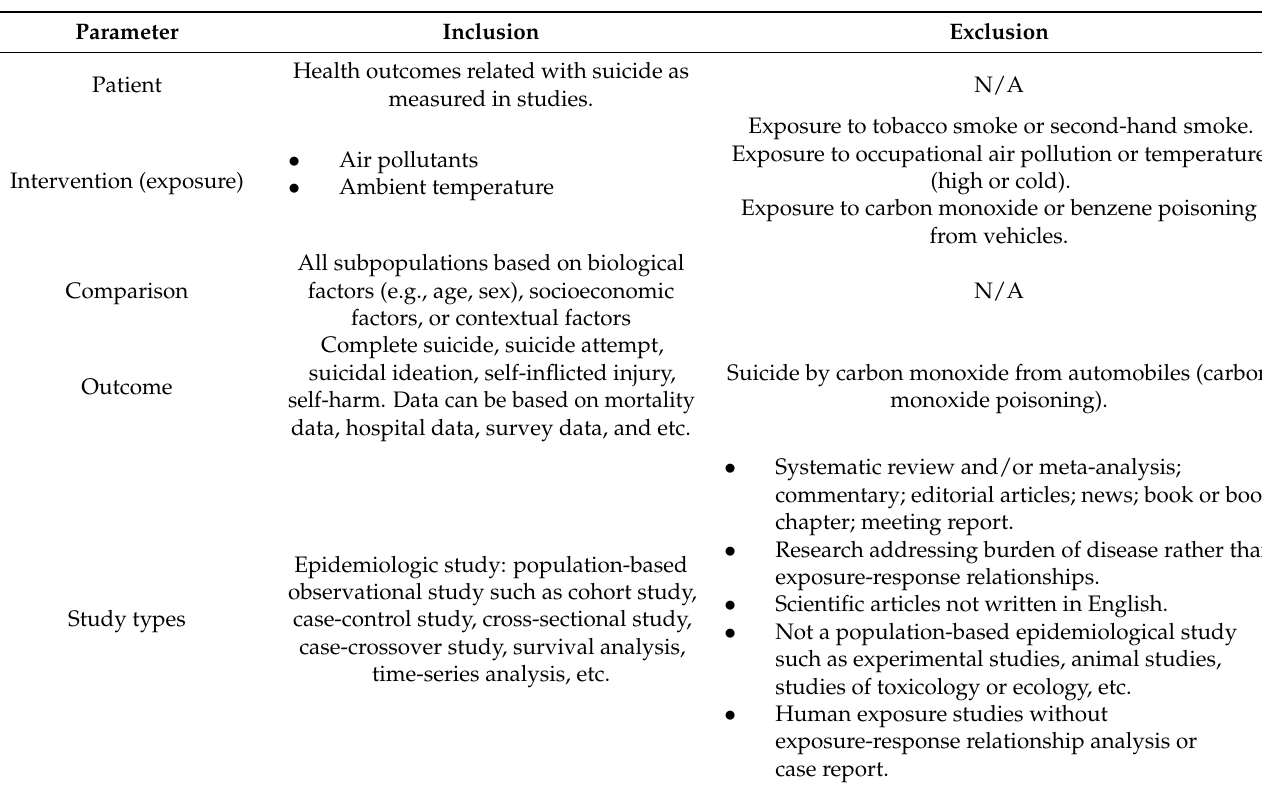
Table 1. PICOS inclusion/exclusion